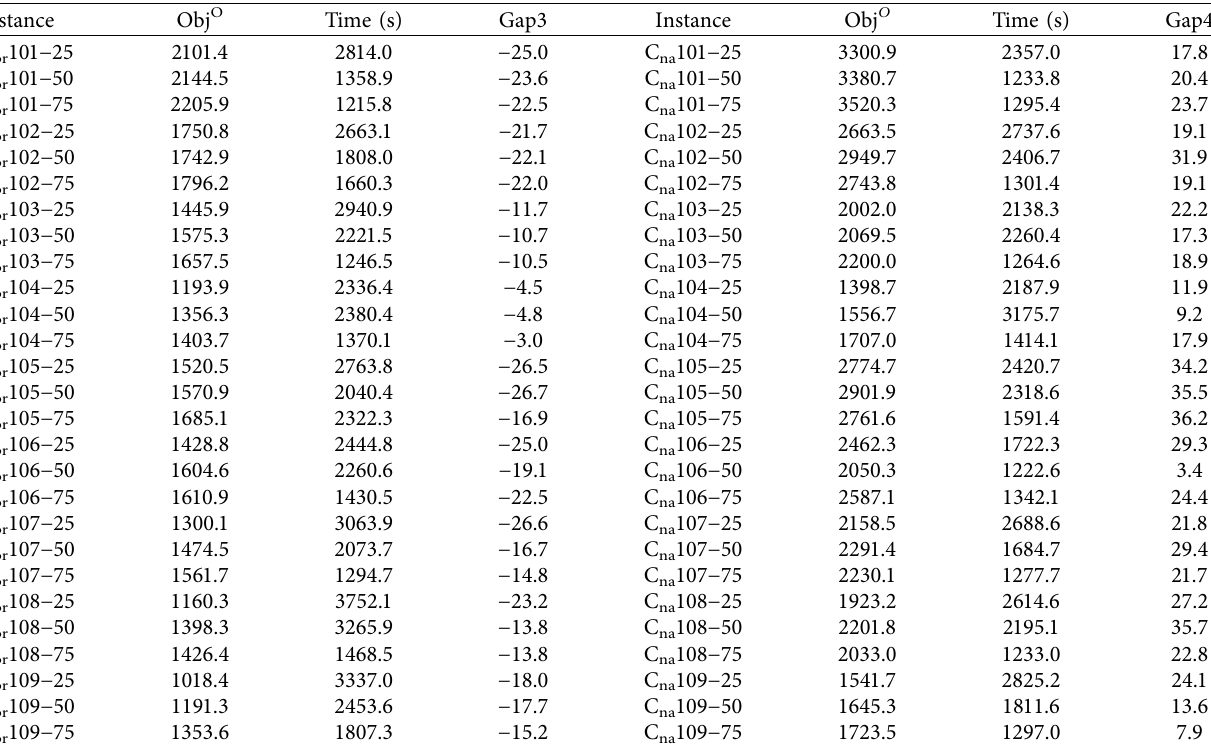
Table 7: Heuristic results of large-scale instances with changed time